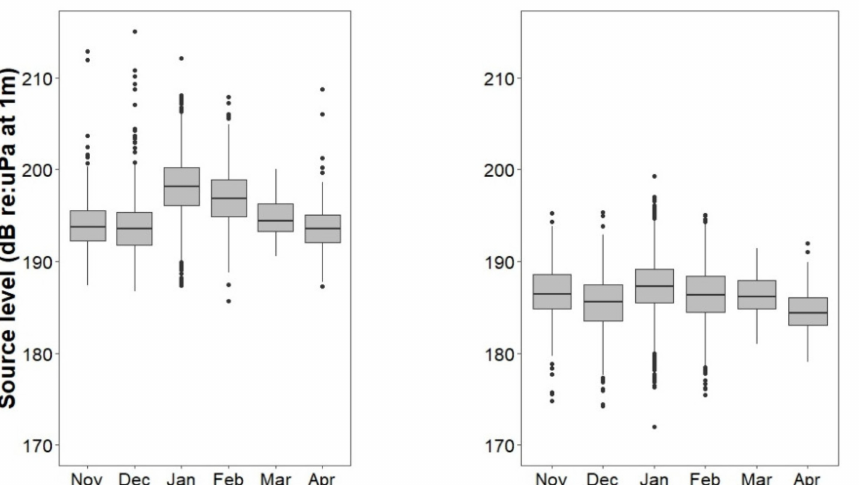
Figure 4. Estimated source levels of fin whale notes by month recorded in the Z-channel ( left ) and the H-channel ( right ) of the OBS off southwest Portugal. The upper and lower whiskers represent the maximum and minimum value of the data within 1.5 times the interquartile range over the 75th percentile and under the 25th percentile,